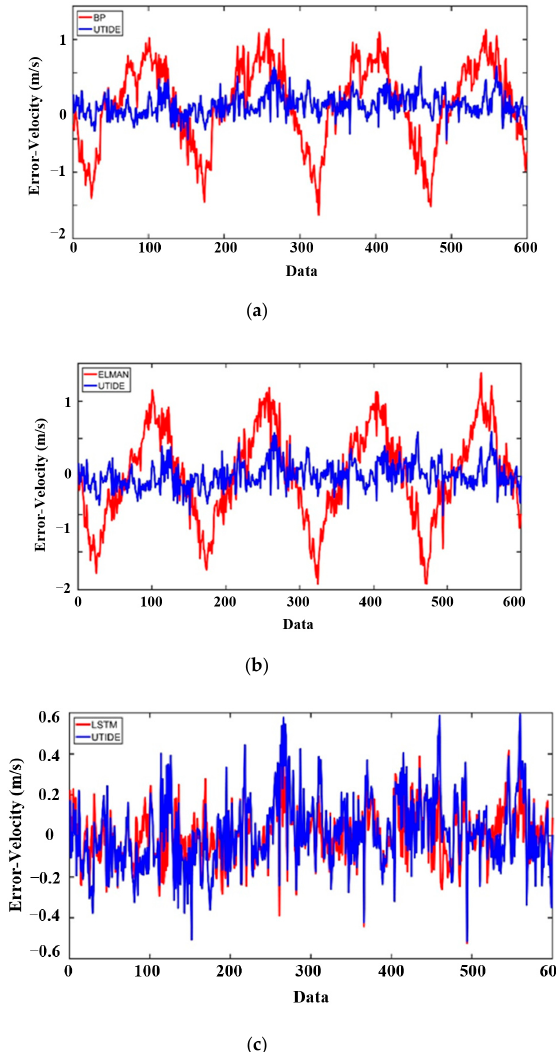
Figure 16. Residual signals of single input prediction method by using three machine learning algorithms and UTide (30 m under sea surface). ( a ) Residual signals by using BP and UTide, ( b ) Residual signals by using ELMAN and UTide, ( c ) Residual signals by using LSTM and UTide.